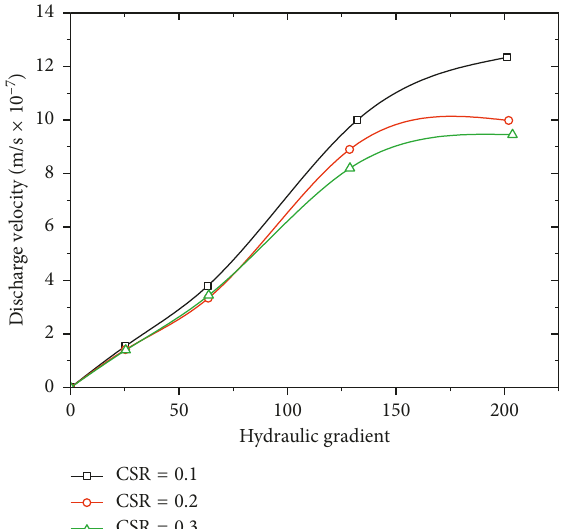
Figure 8: Relationships between the discharge velocity and hydraulic gradient under different CSR values with an N value of